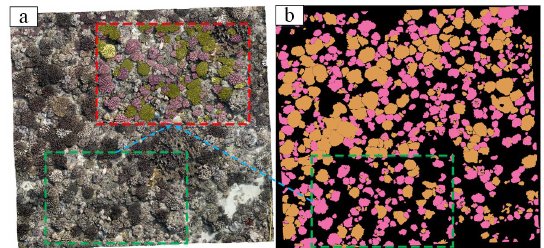
Figure 3 . The picture inside the red rectangle is a partial overlay display of the corresponding parts in (a) and (b), (a) a coral reef orthophoto, (b) a corresponding expert-labelled